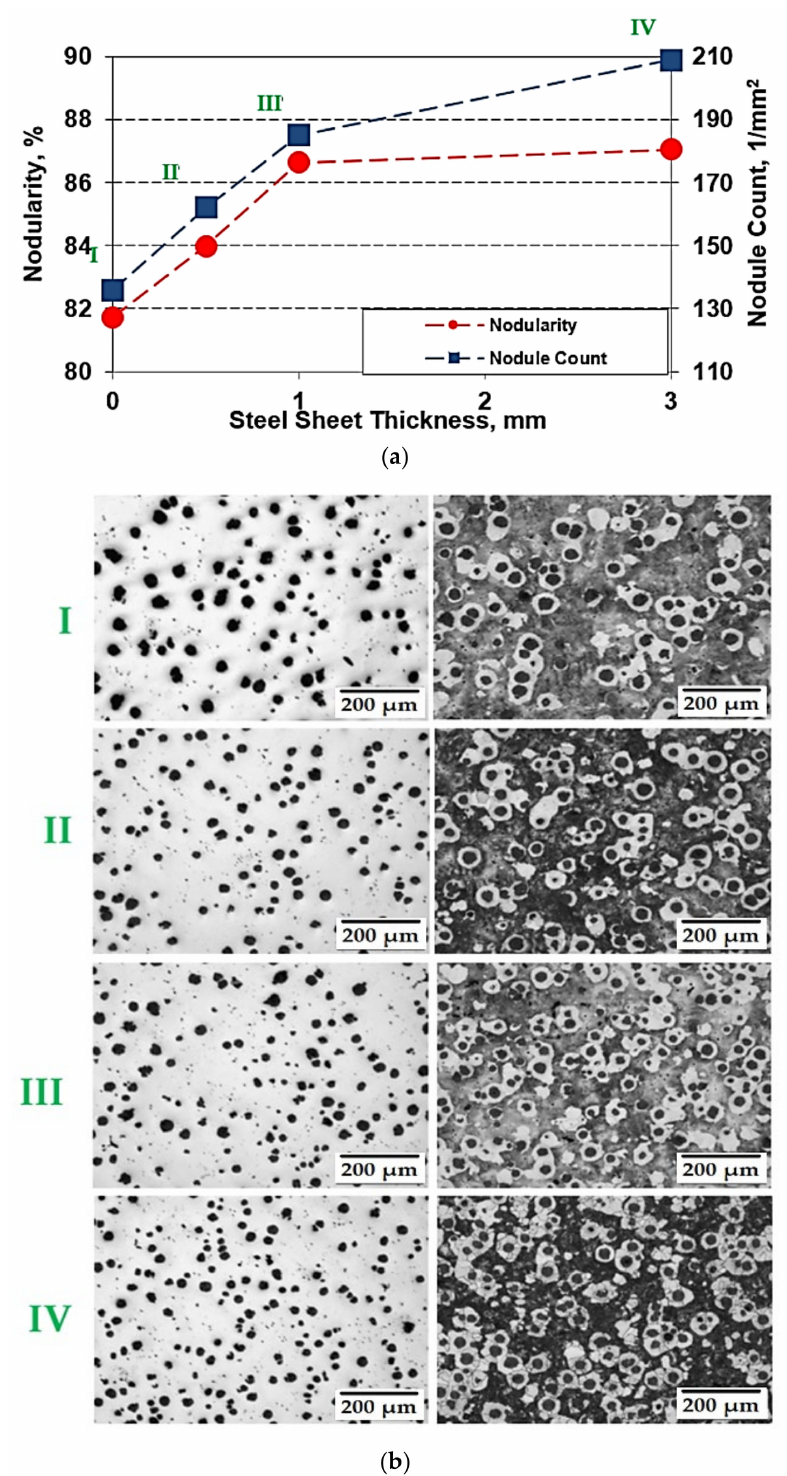
Figure 3. Graphite Nodularity and Nodule Count ( a ) and Structure ( b ) in the casting body as steel sheet thickness influence in un-etching and etching conditions, respectively ( I -sample without steel sheet, II -sample with 0.5 mm steel sheet thickness, III -sample with 1 mm steel sheet thickness, IV -sample with 3 mm steel sheet